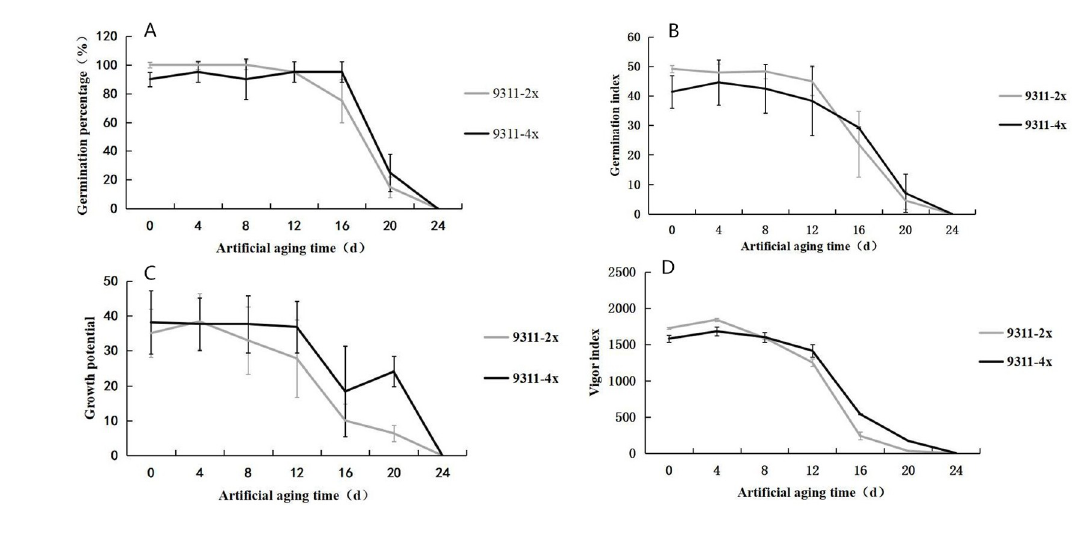
Fig 1. Effect of artificial aging treatment on seed vigor for accessions 9311-2x and 9311-4x. (A) The response of germination rate to the duration of the artificial aging treatment. (B) The response of germination index to the duration of the artificial aging treatment. (C) The response of growth potential to the duration of the artificial aging treatment. (D) The response of seed vigor to the duration of the artificial aging treatment. Values were mean ± SE.